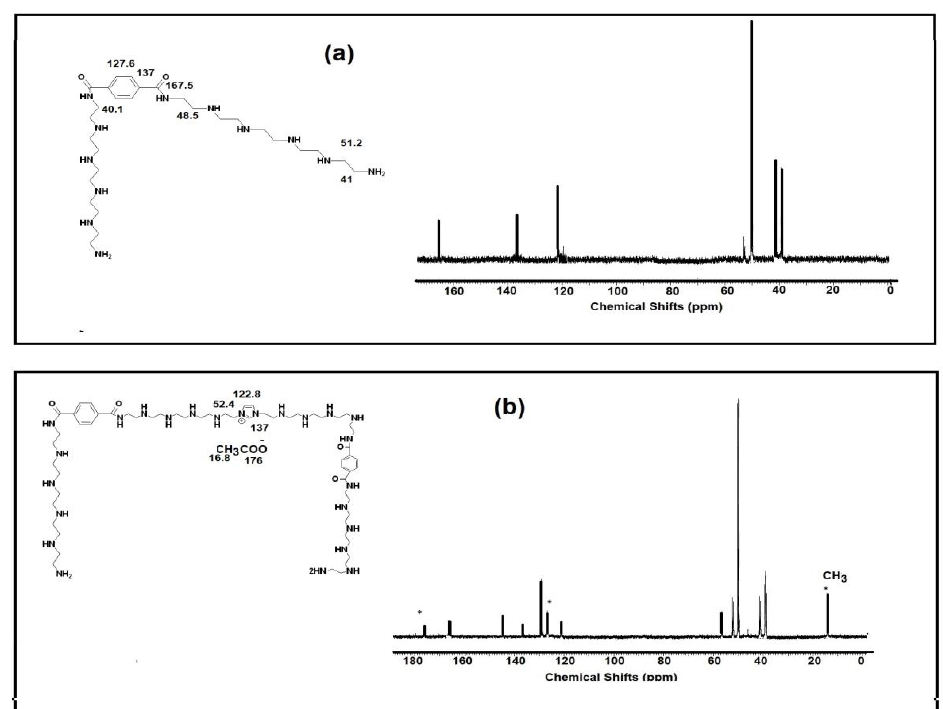
Figure 4. 13 CNMR spectra of ( a ) APA and ( b ) PAIIL.